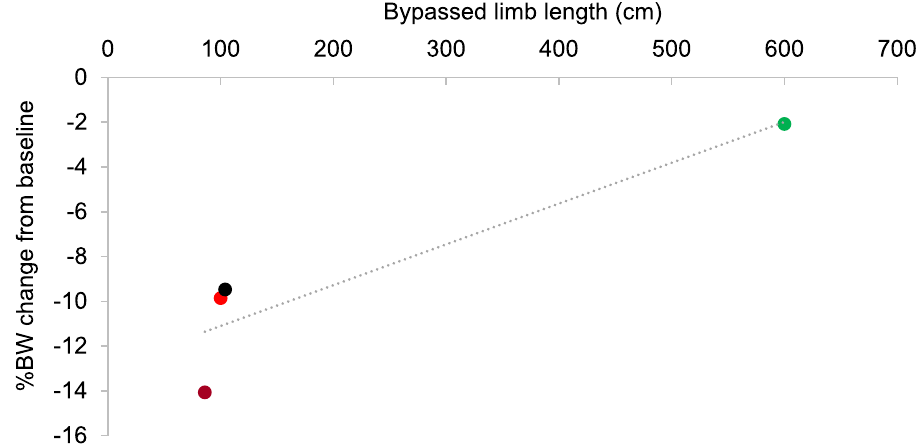
Figure 5. Bypassed limb length as a function of percent body weight change in interventional pigs.